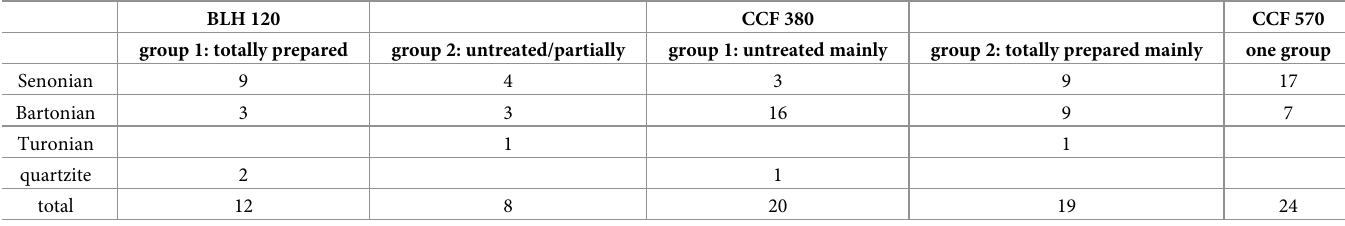
Table 6. Raw materials according the different groups of